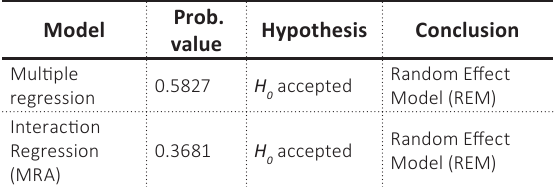
Table 1. Descriptive statistics of variables